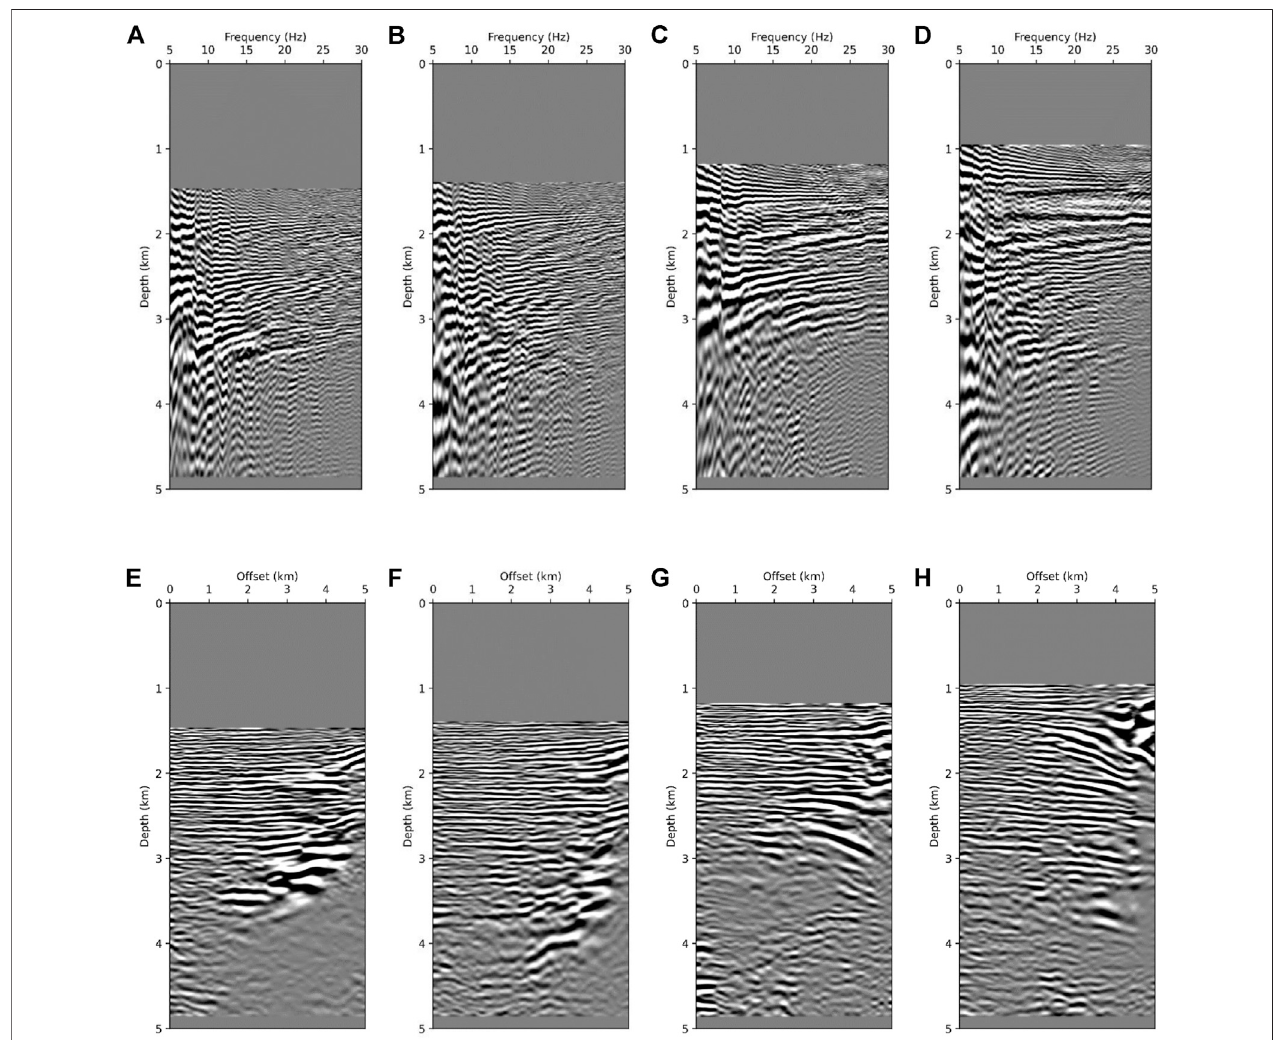
FIGURE14| FourFDCIGsofsmoothedand inverted and20%reducedvelocitymodel byFWIat (A) 6.25 km, (B) 10 km, (C) 17.5 km,and (D) 23.75 km,andfour ODCIGs of same model as that of FDCIGs at (E) 6.25 km, (F) 10 km, (G) 17.5 km, and (H) 23.75 km.